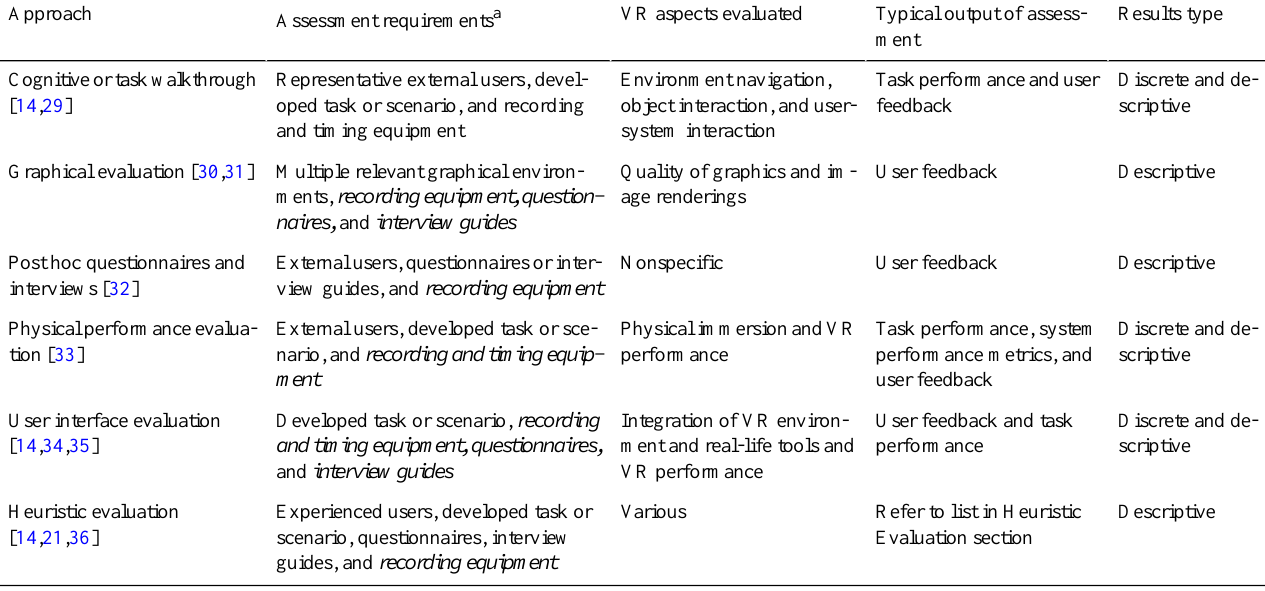
Table 1. Overview of virtual reality (VR) usability assessment